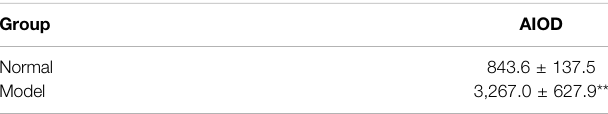
TABLE 2 | The expression of c-fos in the rats